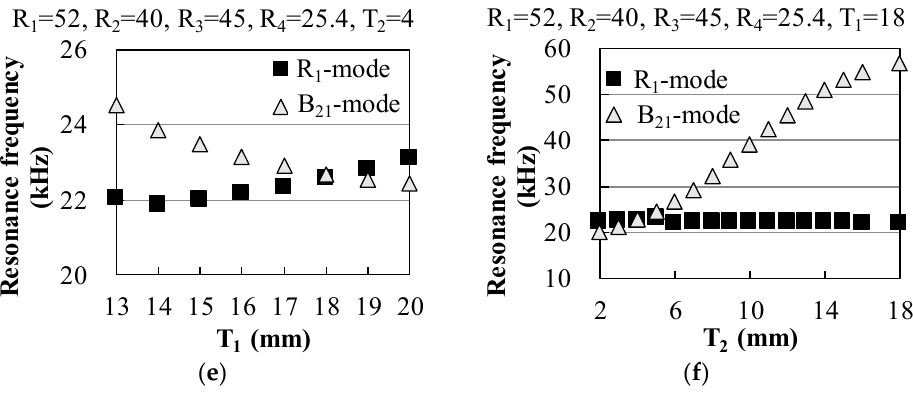
Figure 6. Simulated resonance frequency characteristics for the stator dimensional parameters identified in Figure 5. ( a ) R 1 ; ( b ) R 2 ; ( c ) R 3 ; ( d ) R 4 ; ( e ) T 1 ; and ( f ) T 2 .